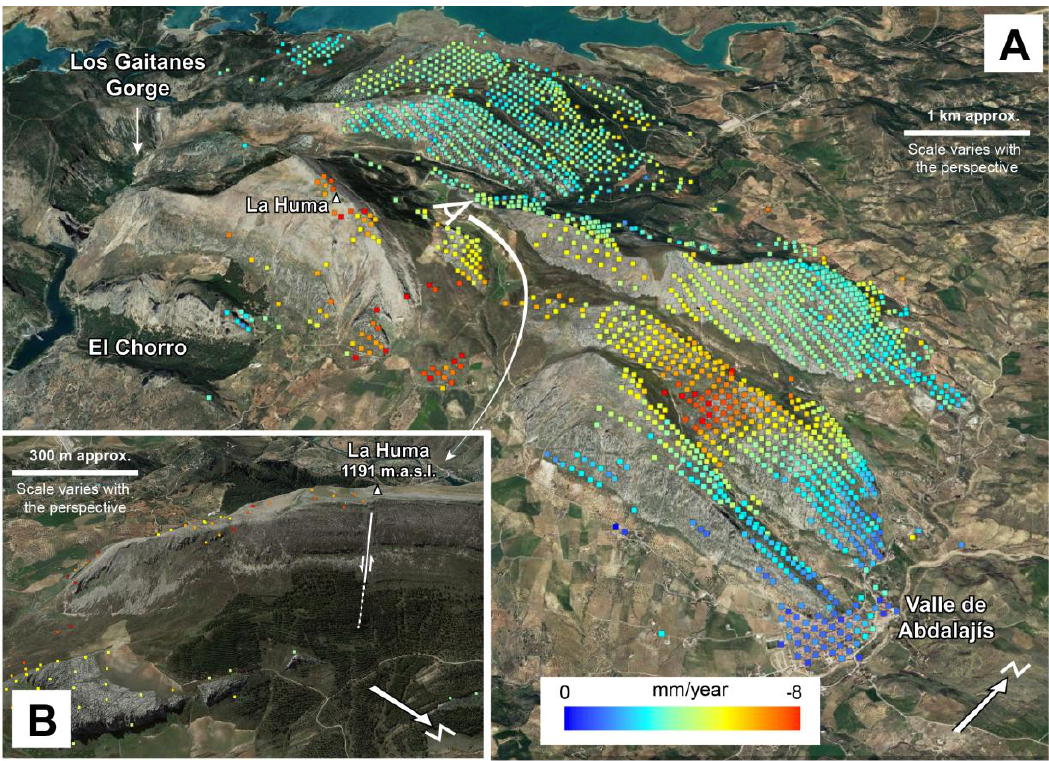
Figure 12. ( A ) Displacement rate data provided by GEP overlaying an oblique northwestward aerial view of the sierras of the Valle de Abdalajís (from Google Earth, www.google.com/earth) ; ( B ) Southwestward aerial view of the La Huma mountain where can be recognized a clear